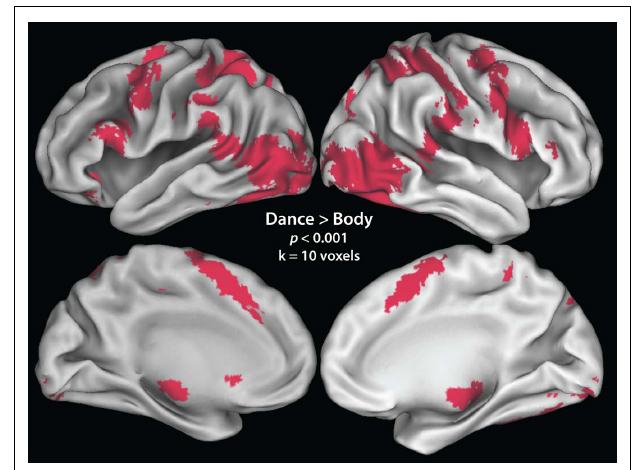
FIGURE 2 | Neural regions active in the contrast comparing all dance observation > static body baseline. This contrast was made to determine, in an unbiased, subject- and task-specific manner, which regions were to be included in the mask of the